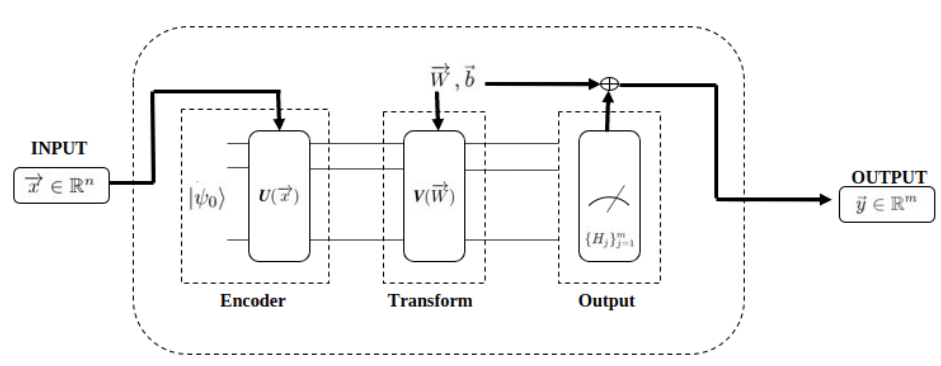
Figure 4. The architecture of a QDNN layer. Reprinted from ref.